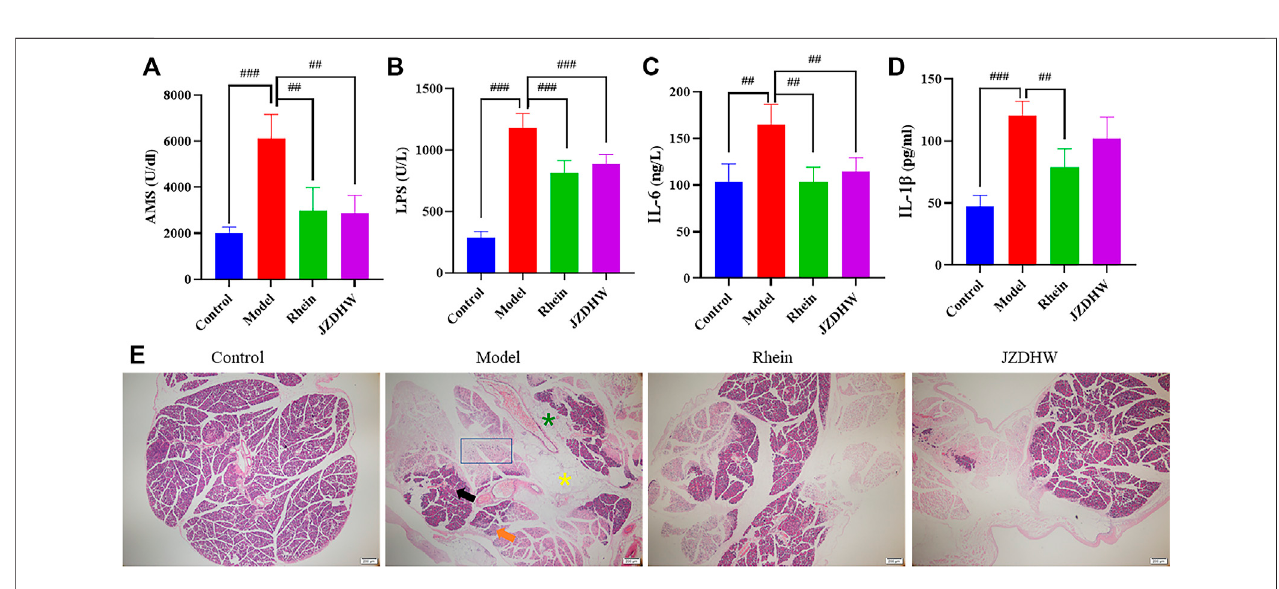
FIGURE 8 | Therapeutic effect of rhubarb and its monomers on pancreatitis. (A) Serum amylase; (B) Lipase; (C) IL-6; (D) IL-1 β ; (E) Tissue section (40 × magni fi cation), indicateshaemorrhage, indicatesoedema, indicatesfattyacid, indicatesin fl ammatorycells,and indicatesnecrosis.Theresultsaregivenas mean ± standard error of the mean ( n = 6). Signi fi cant differences between groups are represented by # for p < 0.05, ## for p < 0.01 and ### for p < 0.001.